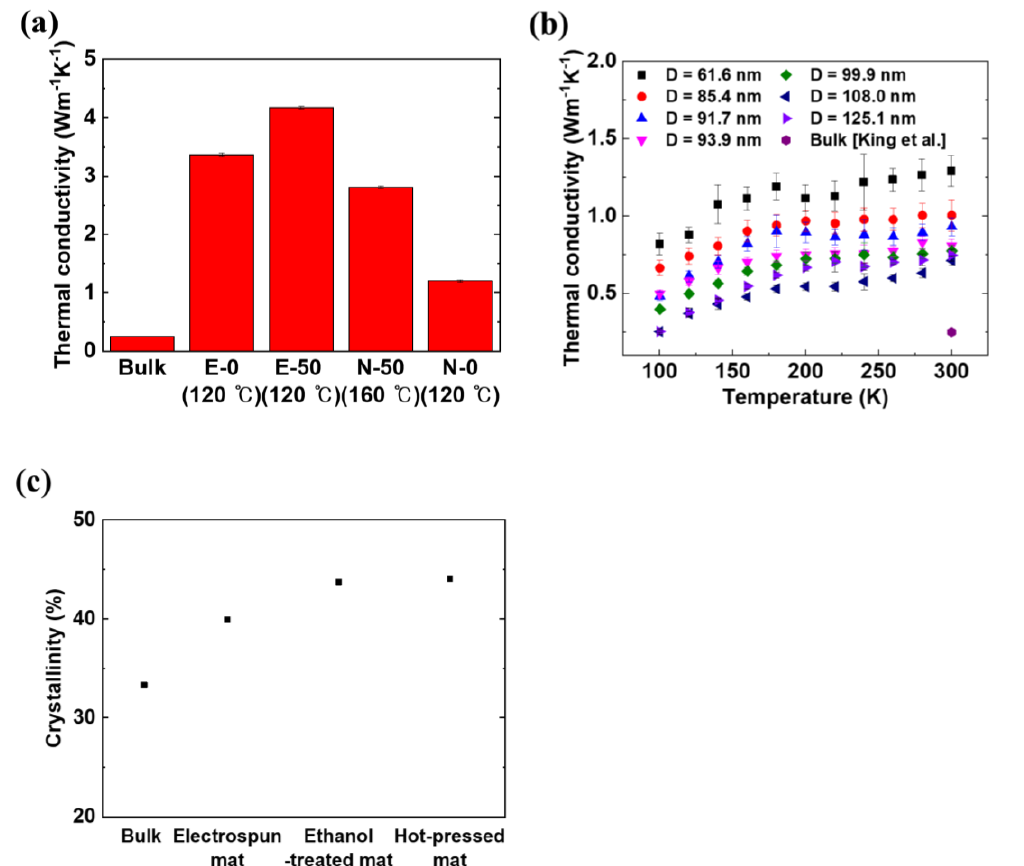
Figure 5. Measured thermal conductivity of mats (E-0 and E-50), films (N-0 and N-50), and electrospun individual NFs and degree of crystallinity of the electrospun mats according to the fabrication stage. ( a ) Thermal conductivity values of four different samples (E-0, E-50, N-50, and N-0) measured at room temperature to clarify the contributions of nanofibrous nylon 66 and deposited Ag to the thermal conductivity. The temperature in parentheses represents the hot-pressing temperature. The thermal conductivity of the mats was increased by the electrospinning and hot-pressing processes, which enhance the alignment of the molecular chains and the crystallinity in the mats. The thermal conductivity value of bulk nylon 66 was taken from previous research [61]. The error bars are not sufficiently large to be seen. ( b ) Measured thermal conductivity of individual electrospun nylon 66 NFs with different diameters, as a function of temperature (100–300 K). The thermal conductivity increases with smaller NF diameter and is 3- to 5-fold higher than that of bulk nylon 66 at room temperature. ( c ) Degree of crystallinity of as-spun, ethanol-treated, and ethanol-treated-hot-pressed (120 °C) electrospun mats, as well as that of bulk nylon 66, which was calculated using the density of